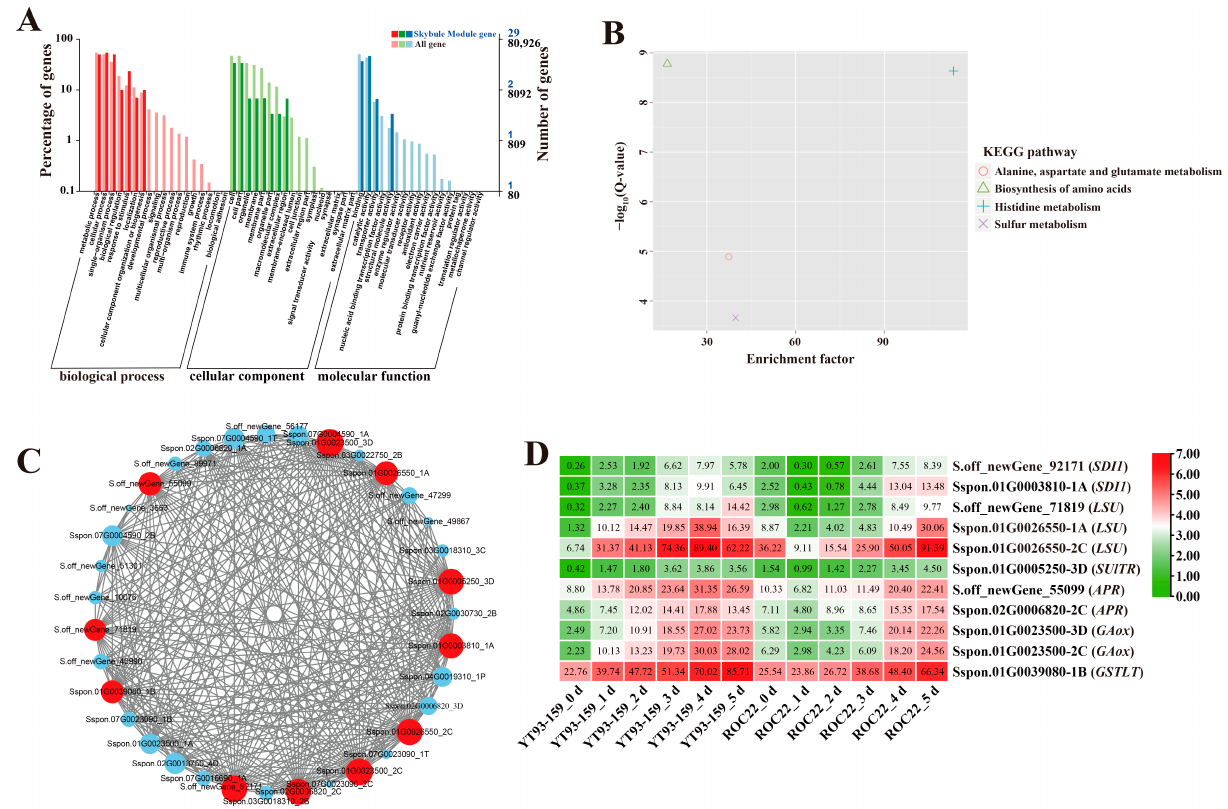
Figure 5. GO enrichment, KEGG enrichment, gene co-expression network, and expression patterns of hub genes in the Skyblue module. ( A ) GO functional enrichment analysis. ( B ) KEGG functional enrichment analysis. ( C ) A gene co-expression network and hub genes. The red represents hub gene, and genes with a higher connectivity in the corresponding network are shown in larger circles. ( D ) The expression patterns of hub genes. YT93-159_0 d to _5 d and ROC22_0 d to _5 d represent YT93-159 and ROC22 at 0 d to 5 d post- S. scitamineum inoculation, respectively.